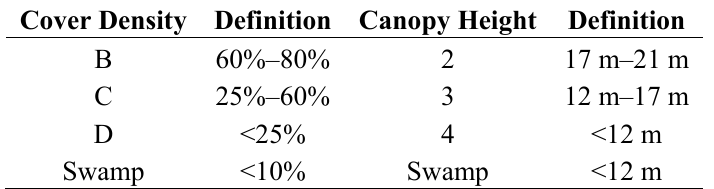
Table 1. Classification of forest characteristics into forest types